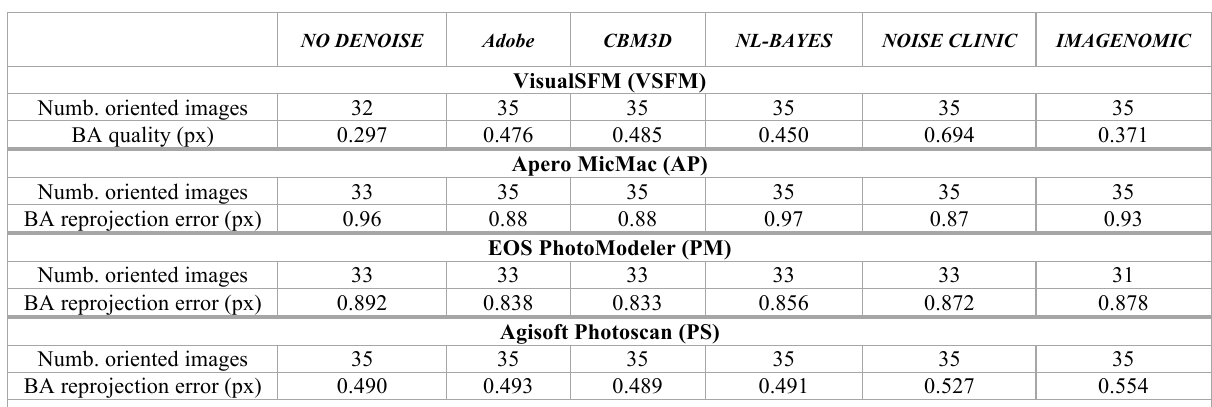
Table 2: Bundle adjustment (BA) results of the denoising methods applied to the enhanced